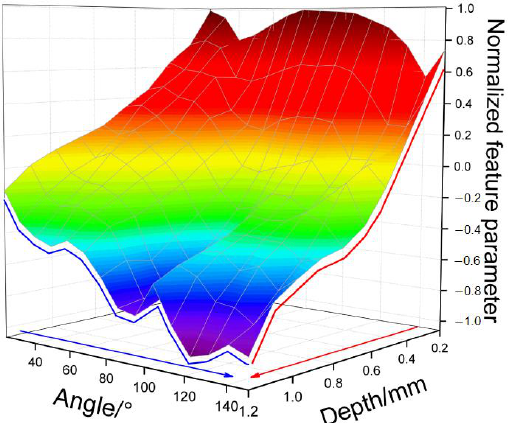
Figure 16. Three-dimensional map of depth and angle versus feature parameter.